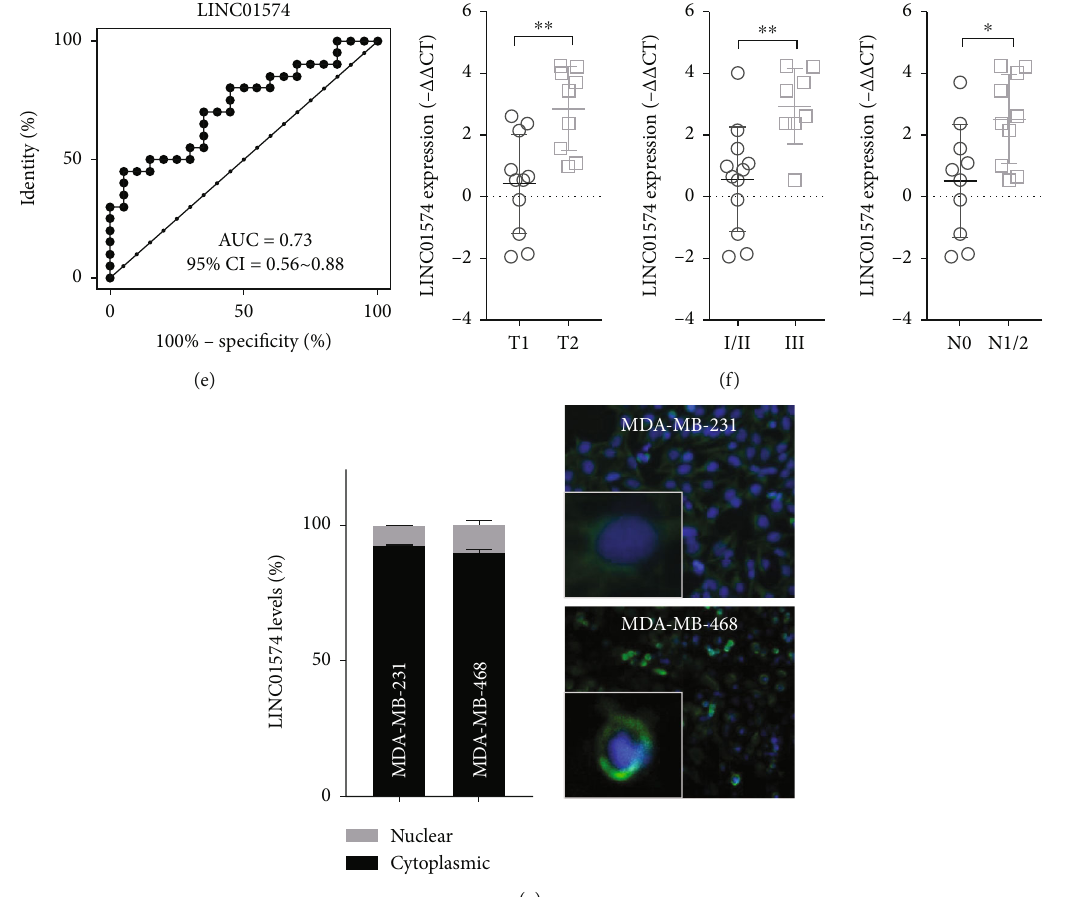
Figure 1: LINC01574 expression was elevated in BC and was positively related to adverse outcomes. (a) Volcano plots showed the di ff erentially expressed lncRNAs between BC tumor and normal tissues. (b) Heat maps showed the OS-related di ff erentially expressed lncRNAs. OS: overall survival; BC: breast cancer. (c) The transcription level of LINC01574 was tested via RT-PCR. (d) The quantitative determination of LINC01574 mRNA level in BC tumor tissues through using qRT-PCR. (e) Receiver operative characteristic of LINC01574. (f) The levels of LINC01574 in di ff erent BC tumor sizes, histological stages, and lymph node metastasis. (g) The distributions of LINC01574 in BC cells were analyzed by subcellular localization analysis. ∗ P < 0 : 05 , ∗∗ P < 0 : 01 , and ∗∗∗ P < 0 : 001